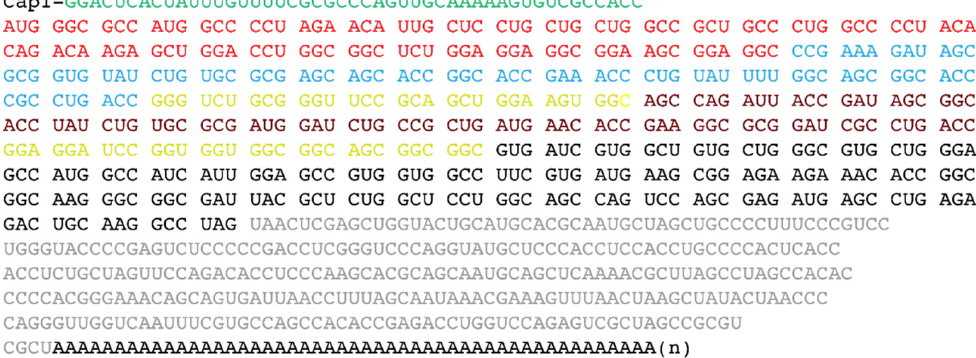
Figure A1. Sequence of the mRNA vaccine. The sequence of the mRNA vaccine is depicted with each functional domain highlighted in colour: in green the 5 ′ UTR (eIF4G aptamer), in red the leader sequence, in blue the TCR beta CDR3, in yellow the linkers, in brown the TCR alpha CDR3, in black the transmembrane and cytoplasmic domains and in grey the 3 ′ UTR.